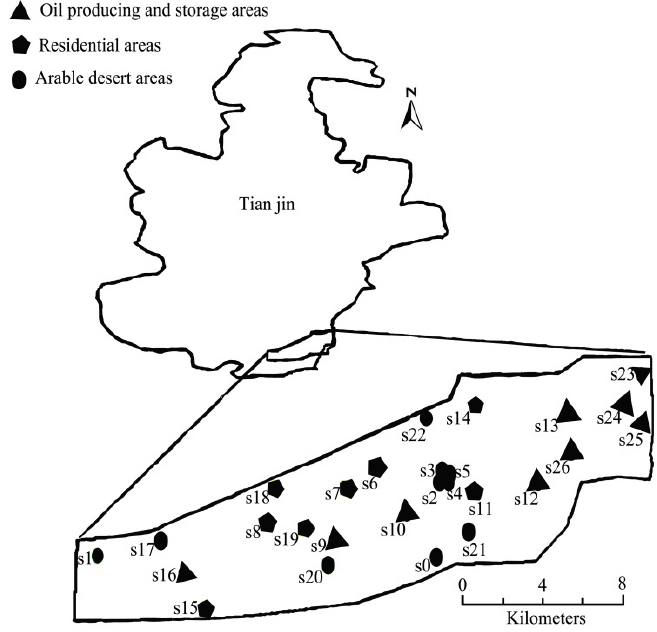
Figure 1. Map of study area and location of sampling